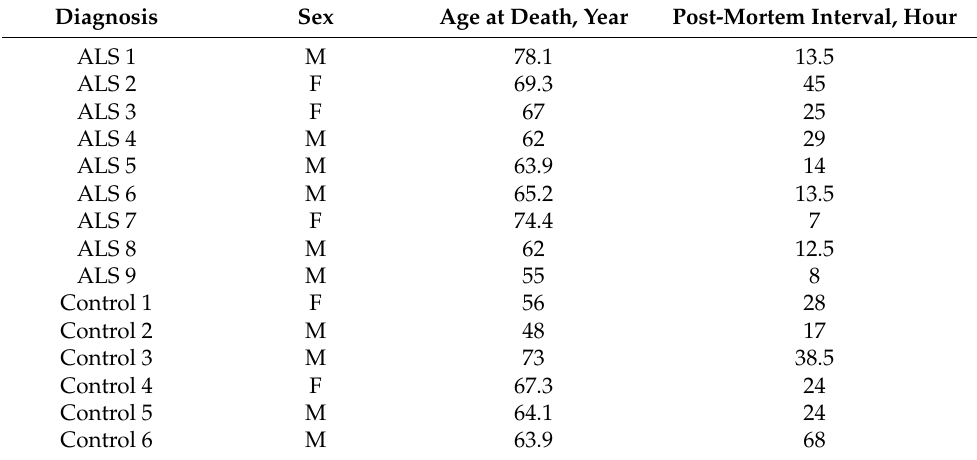
Table 1. ALS case and control